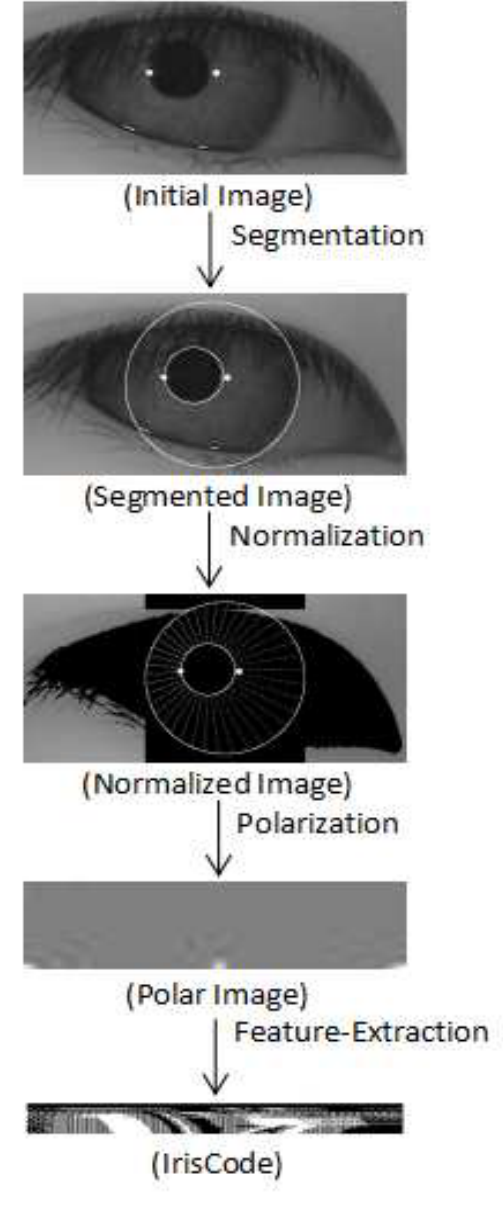
Figure 3. Steps for generating